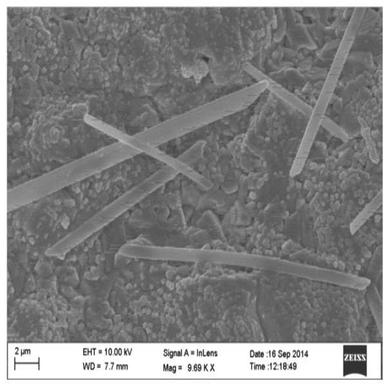
Nanostructure (scanned by SEM) ensembles of Cu grown electrochemically through multipore filter of Makrofol-KG.